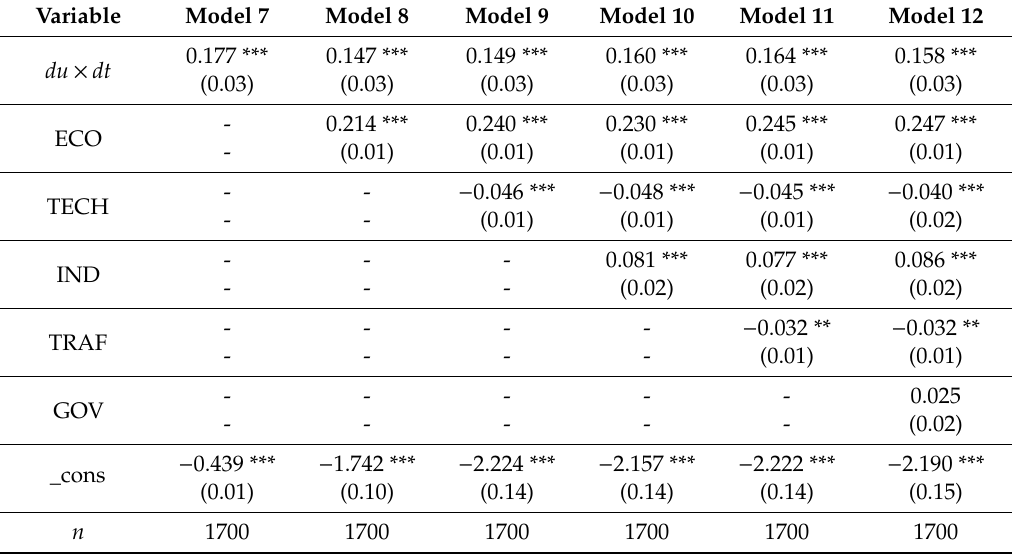
Table 5. Regression results after changing the treated